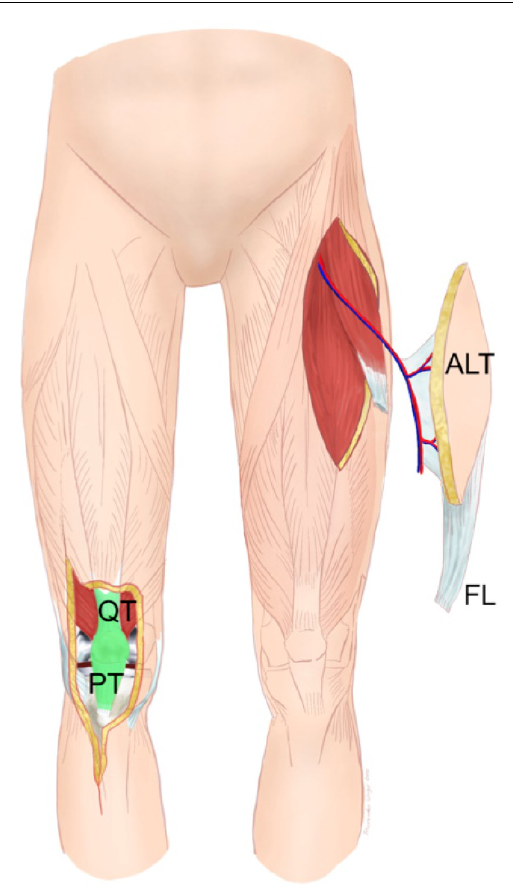
Figure 10: Free anterolateral thigh (ALT) flap with fascia lata (FL): Clinical scenario of PJI after TKA with a large soft-tissue defect of up to 10 cm in width and an underlying extensor apparatus deficiency with complete loss of the patellar tendon (PT), quadriceps tendon (QT), or a combination of both (green). The ALT flap is raised off the contralateral leg with the vascularized FL to reconstruct the damaged contralateral extensor apparatus (Table 1: Patient No. 1; additional Figures 3,